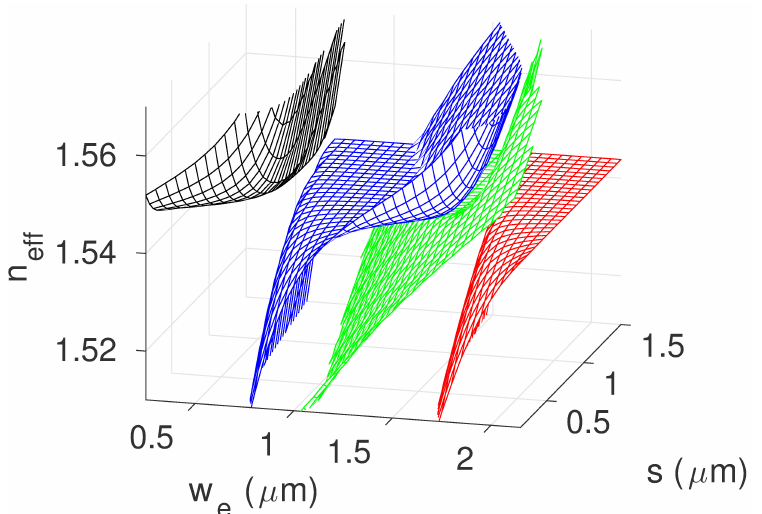
Figure 5. (Real part of the) effective indices of the TE quasi-modes propagating in the asymmetric concentric two-ring structure of Figure 1 as the two design parameters w e and s are varied. Four quasi-modes can be observed in the ( w e , s ) range depicted in the figure.